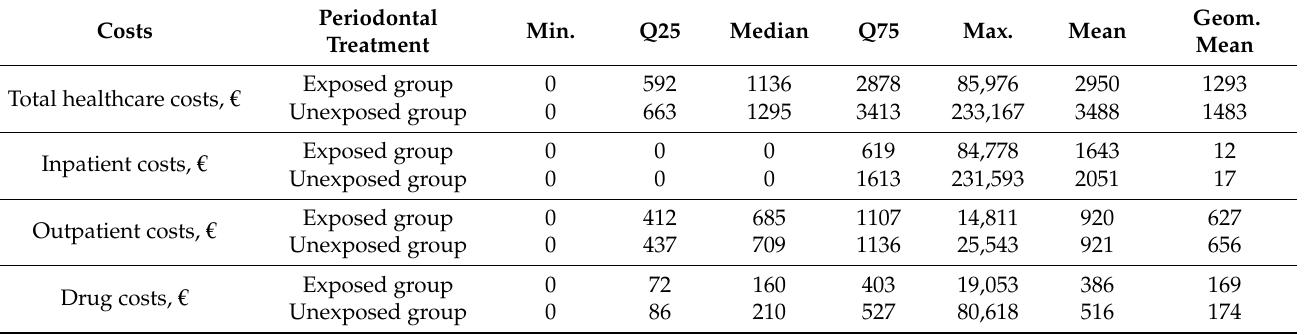
Table 2. Descriptive statistics of the different kinds of healthcare costs in the third year after the index